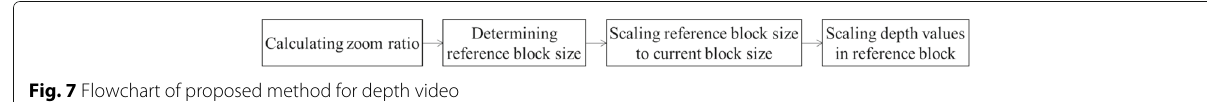
Figure 8 shows an example of zoom motion estimation for the depth video. Areas surrounded by the red rectan- gle in Fig. 8a and b are the 8 × 8 current and reference blocks, respectively, and Fig. 8 c and d show the depth val- ues in each block. d cur and d ref for each 8 × 8 block are about 679.625 and 776.969, respectively, so s is calculated as about 0.874. If α is set to 0.965, the reference block size is determined as 7 × 7 as shown in Fig. 8 e when the cur- rent block size is 8 × 8. Then, a 7 × 7 reference block is